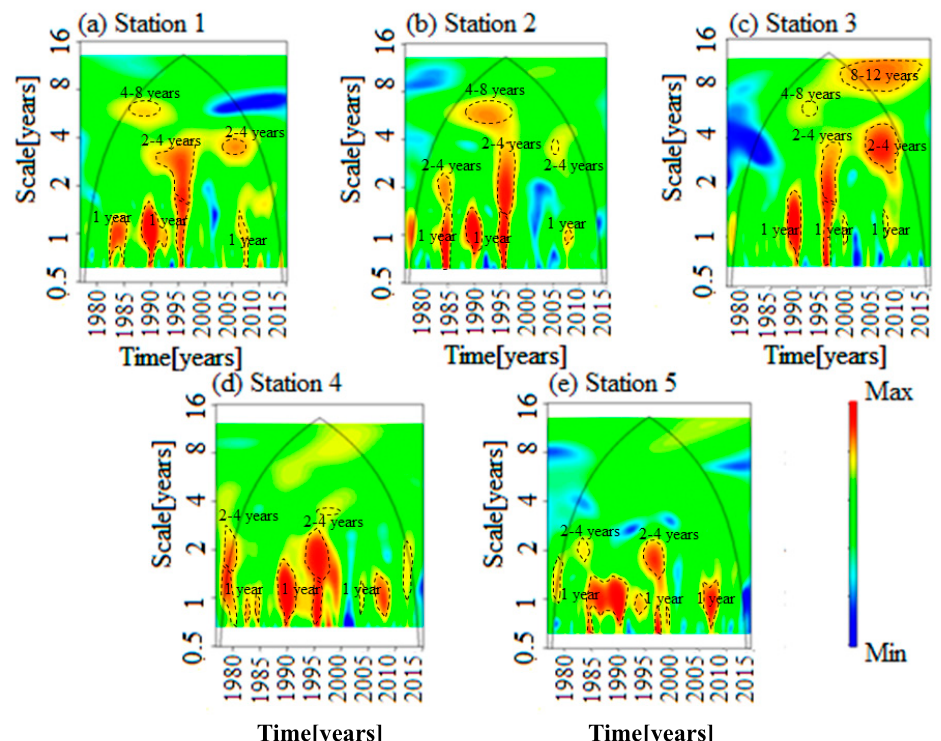
Time[years] Time[years] Figure 4. Wavelet spectrum of monthly rainfall (1977–2015) for 5 stations in Gabes Watershed. Annual scale (1 year), Inter-annual scales (2–4, 4–8 and 8–12 years). ( a ): Station 1, ( b ): Station 2, ( c ): Station 3, ( d ): Station 4, ( e ): Station 5. Table 1. Time variation of rainfall Mode variability (annual and inter-annual) from wavelet spectrum analysis for 5 stations in Gabes Basin